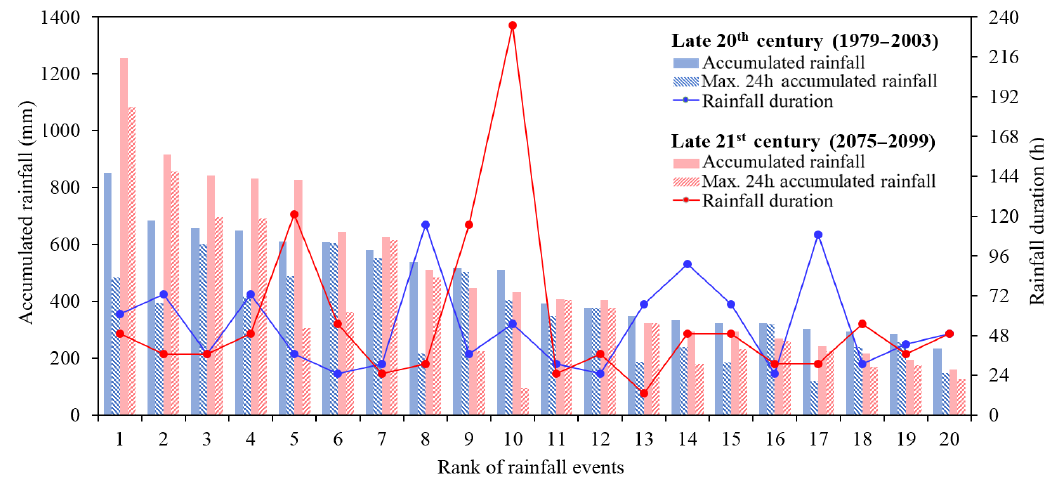
Figure 5. Top 20 rainfall events of the late 20th and 21st centuries.